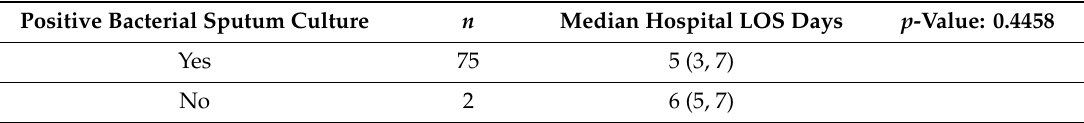
Table 4. Hospital length of stay for positive sputum